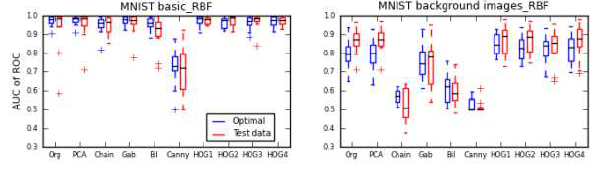
Figure 7. Performance by each feature only with SVM-RBF